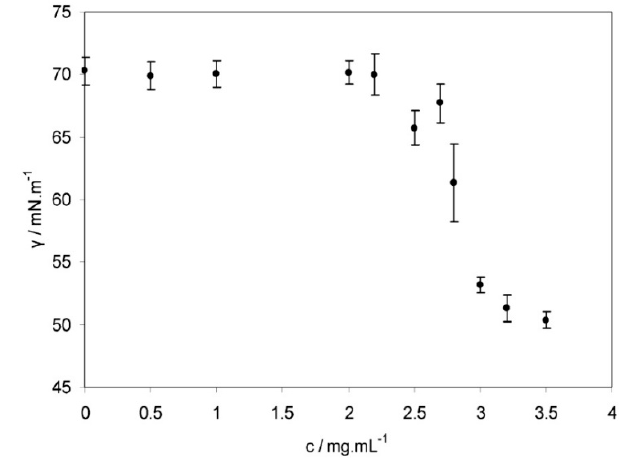
Figure 9. Surface tension of sodium hyaluronate solutions as a function of polymer concentration. Reproduced from [60], with permission from American Chemical Society, 2020.